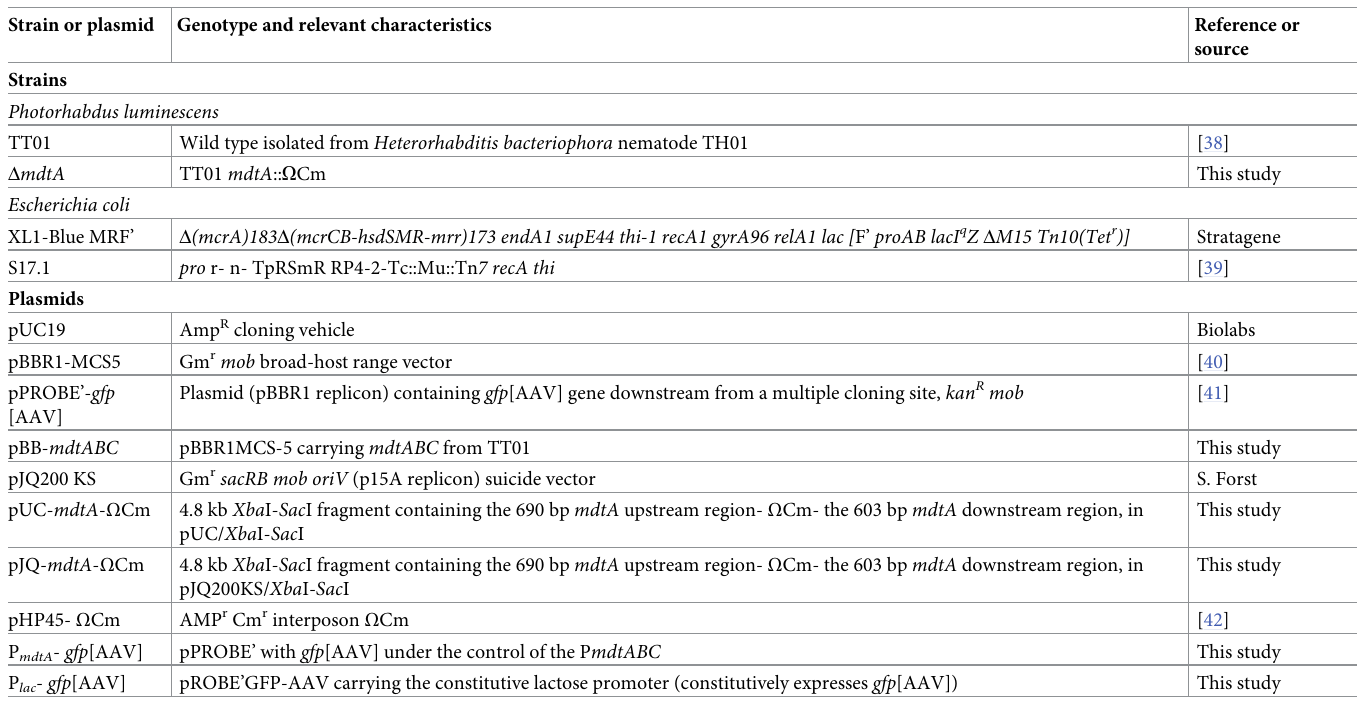
Table 1. Strains and plasmids used in this